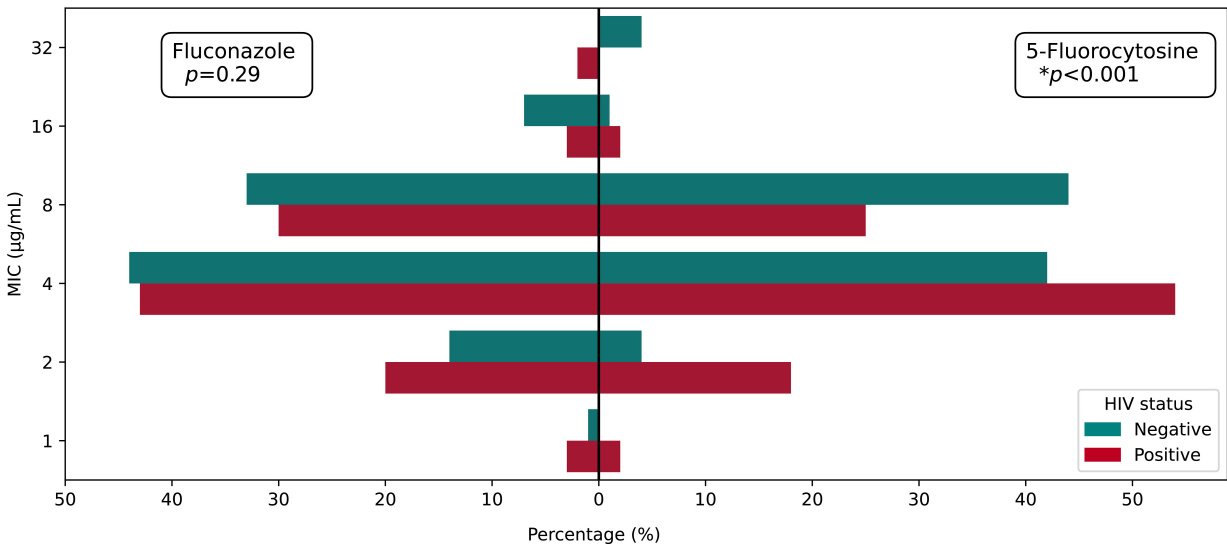
Frontiers in Microbiology |